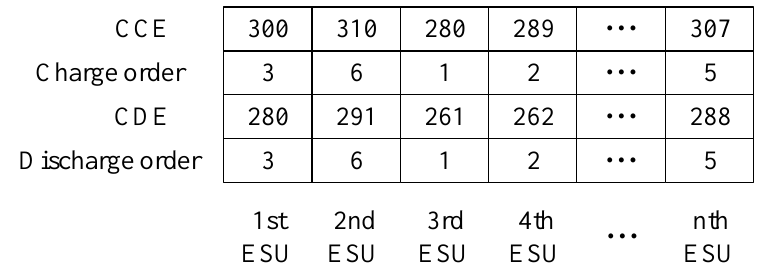
Figure 9. ESU charge-discharge order by accumulative. Cumulatively charged energy (CCE); cumulatively discharged energy (CDE).